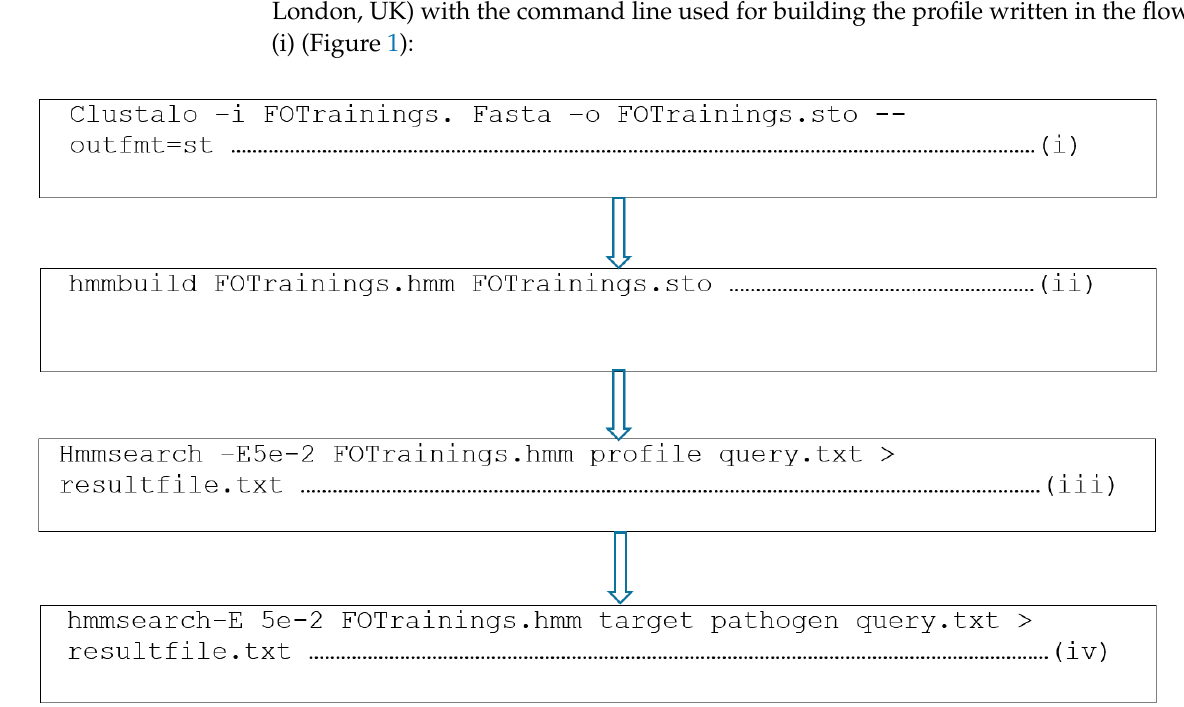
Figure 1. Flow chart of the HMMER command lines. The command line (i) in the flow chart above used “Clustalo” module of the HMMER software for the multiple alignment and GCG postscript output for the graphical printing of the AMPs. The command line hmmbuildin (ii) built the aligned sequences in (i) to enhance the construction of the profile by showing common motifs/signatures within the profile. The command line hmmsearchin (iii) evaluated the performance of the resulting constructed profile in (ii) by querying it on independent datasets. The command line (iv) allowed the identification of the anti- Fusarium oxysporum AMPs.